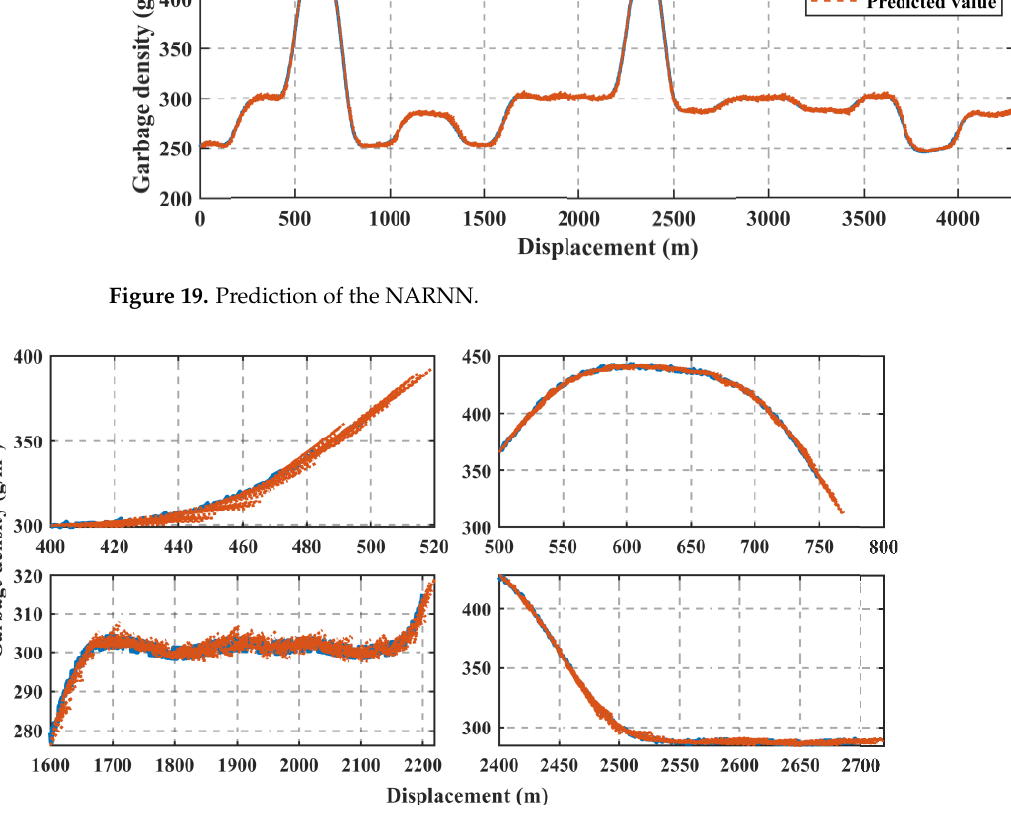
Figure 20. Magnified prediction details.